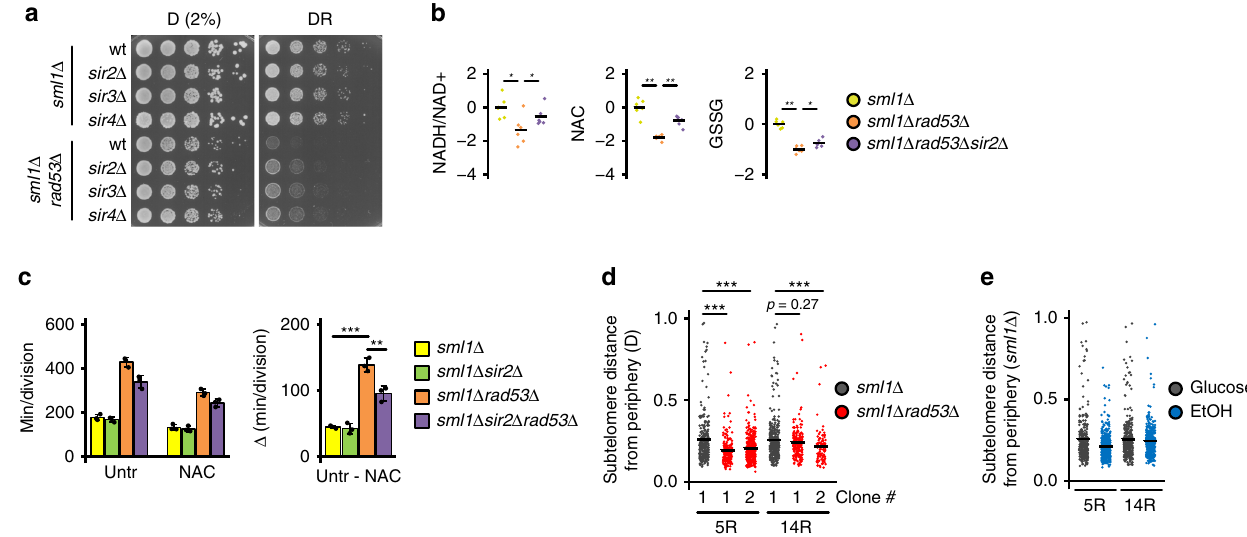
Fig. 3 Subtelomere expression mediates glucose starvation tolerance. a 10 7 cells/mL were serially diluted (1:6), spotted on YP plates with the indicated carbon sources and grown for 2d. b Mass spectrometry analysis of redox metabolites in cells of the indicated genotypes cultured in low glucose. Metabolite levels were normalized by the median of all detected metabolites. Signi fi cances were calculated by Kruskal – Wallis rank sum test ( p NADH/NAD + = 0.019, p = 0.0011, p = 0.0011), followed by Mann – Whitney test (two-sided) with Benjamini – Hochberg correction ( p = 0.041, NAC GSSG NADH/NAD + _ sml1 Δ rad53 Δ _vs_ sml1 Δ p = 0.041, p = 0.0021, p = 0.0021, p = NADH/NAD + _ sml1 Δ rad53 Δ sir2 Δ _vs_ sml1 Δ rad53 Δ NAC_ sml1 Δ rad53 Δ _vs_ sml1 Δ NAC _sml1 Δ rad53 Δ sir2 Δ _vs_ sml1 Δ rad53 Δ GSSG_ sml1 Δ rad53 Δ _vs_ sml1 Δ 0.0043, p GSSG_ sml1 Δ rad53 Δ sir2 Δ _vs_ sml1 Δ rad53 Δ = 0.026). n = 6 independent culture replicates. c Cells were inoculated in YP + low glucose with or without supply of 1 mM N -acetylcysteine, and division speed was determined by cell counting over 2 days. The right panel indicates the reduction of division time by N -acetylcysteine. Signi fi cances were calculated with one-way ANOVA ( p = 2.4 × 10 − 6 ) with post hoc Tukey HSD test ( p sml1 Δ rad53 Δ _vs_ sml1 Δ = 0.0000052, p sml1 Δ rad53 Δ sir2 Δ _vs_ sml1 Δ rad53 Δ = 0.0014). n = 3 independent experiments. d , e Jitter plots representing the distance of labeled subtelomeres 5 R and 14 R from the nuclear periphery. d Cells were cultured in normal glucose. Data from one parental sml1 Δ control and two independent sml1 Δ rad53 Δ clones (#1, #2) are shown. e sml1 Δ controls were cultured in the indicated carbon sources. Signi fi cances were calculated by Kruskal – Wallis rank sum test ( p D_5R = 8.5 × 10 − 15 , p D_14R = 0.00039), followed by Mann – Whitney test (two-sided) with Benjamini – Hochberg correction ( p D_5R_ sml1 Δ rad53 Δ #1_vs_ sml1 Δ = 3.1 × 10 − 13 , p D_5R_ sml1 Δ rad53 Δ #2_vs_ sml1 Δ = 6.8 × 10 − 10 , p D_14R_ sml1 Δ rad53 Δ #1_vs_ sml1 Δ = 0.27, p D_5R_ sml1 Δ rad53 Δ #2_vs_ sml1 Δ = 8.9 × 10 − 5 ). n cells from X independent experiments ( n /X): subtelomere 5R D_ sml1 Δ = 301/3, D_ sml1 Δ rad53 Δ #1 = 181/2, D_ sml1 Δ rad53 Δ #2 = 353/3, EtOH_ sml1 Δ = 419/3, subtelomere 14R D_ sml1 Δ = 368/2, D_ sml1 Δ rad53 Δ #1 = 209/2, D_ sml1 Δ rad53 Δ #2 = 104/1, EtOH_ sml1 Δ = 415/2. Bars plots with error bars represent mean values and standard deviation, D glucose; DR glucose restriction (0.01% in solid media, 0.04% in liquid media), EtOH ethanol; NAC N -acetylcysteine; GSSG oxidized glutathione. * p < 0.05, ** p < 0.01, *** p <